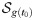
Intersections of the stochastic trajectories with a transversal section Sg(t0).(A) Schematic representation of the intersections. (B) We consider an adapted coordinate system (x1, …, x10) (see S1 Sect. 1) so that (x2, …, x10) are orthogonal coordinates on Sg(t0) and then consider the distribution Pk, r of the values of xk for k = 2, …, 10 at the intersection points Qg(t0)(r). Quantile-Quantile (Q-Q) plots of these distributions for the fourth pass, Qg(t0)(r=4), show that the distributions are very close to being normal, (see Fig C in S2 Appendix for similar plots for r = 1, 2, …, 8). (C) KS distances between the above distributions for the first r = 1, 2, …, 7 rounds of the stochastic trajectory and the distribution in the 8th round (r = 8), k = 2, 3, …, 10.